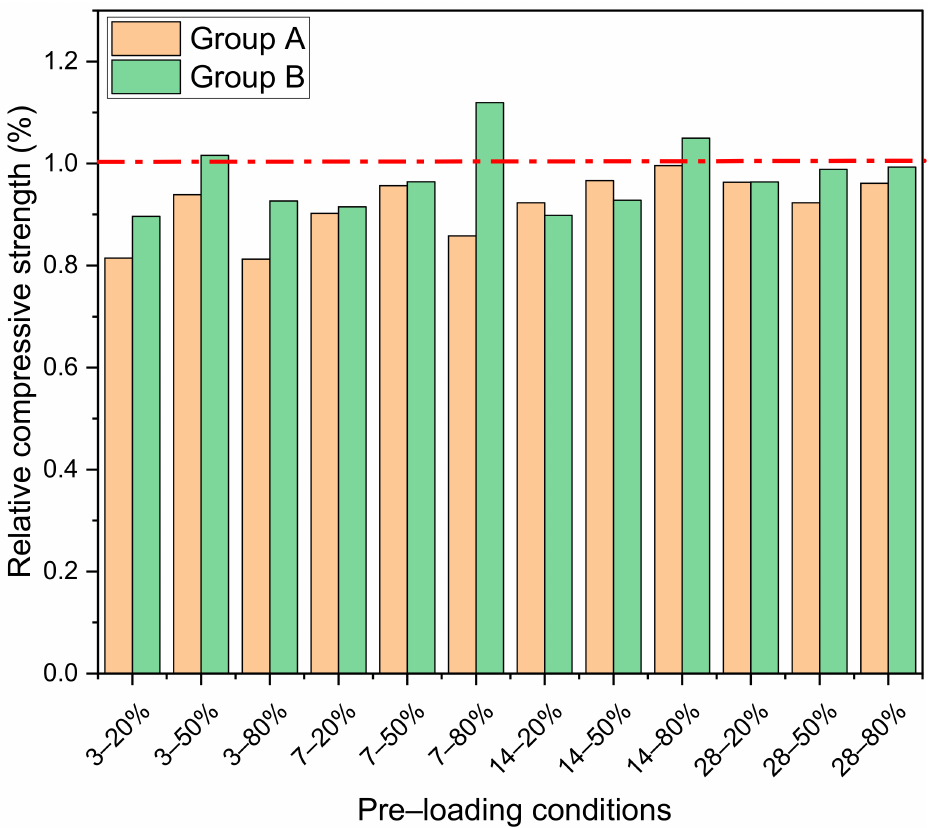
Figure 4. The relative compressive ratio results between pre-loading samples and virgin